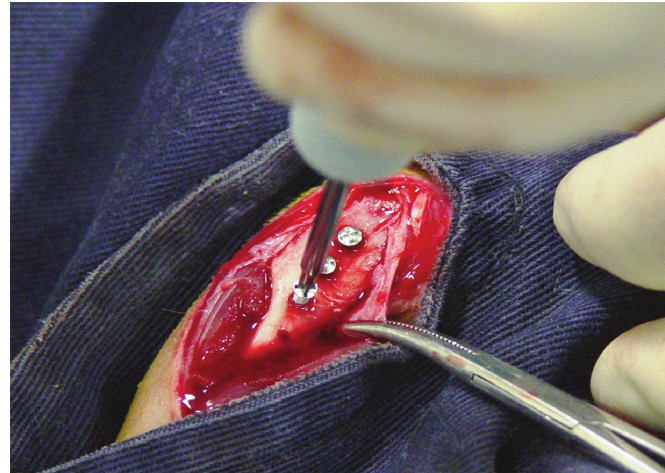
FIGURE 1 - Screw insertion in rabbit bone tissue.